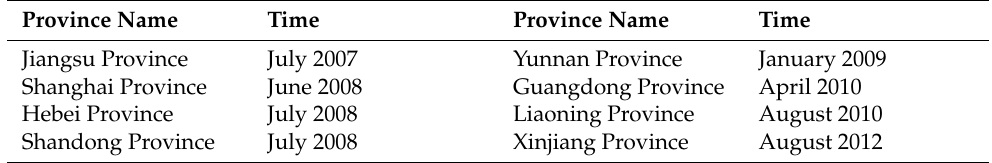
Table 2. Adjustment time of COD pollution fee collection standards during the sample